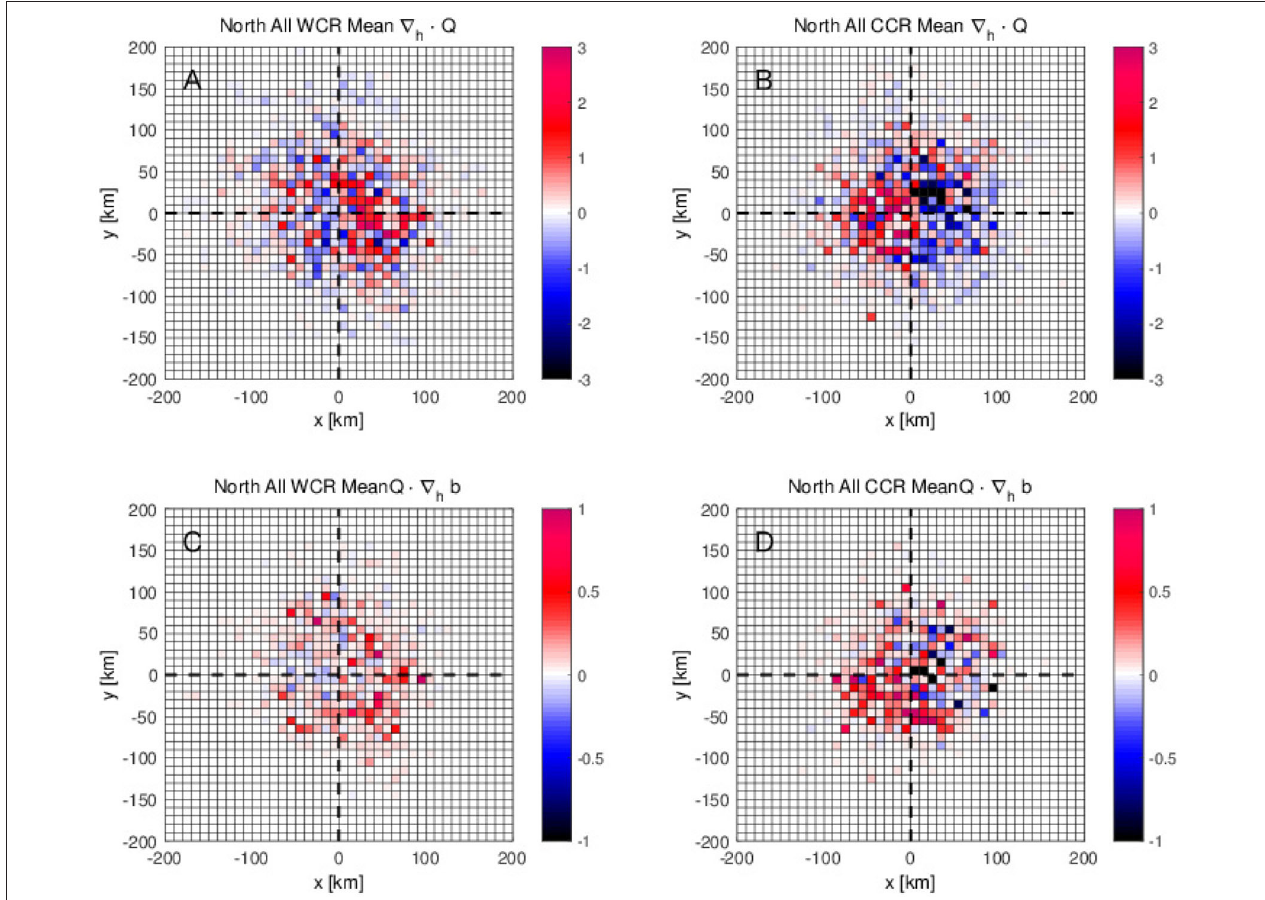
FIGURE 8 | (A,B) Average divergence of Q-vector ∇ h · Q (4) and (C,D) average frontogenetical function Q ·∇ h b (5) as a function of zonal and meridional distance from the center of the closest eddy to the fishing location for (A,C) warm-core rings (WCR) and for (B,D) cold-core rings (CCR) in the northern fishing site.